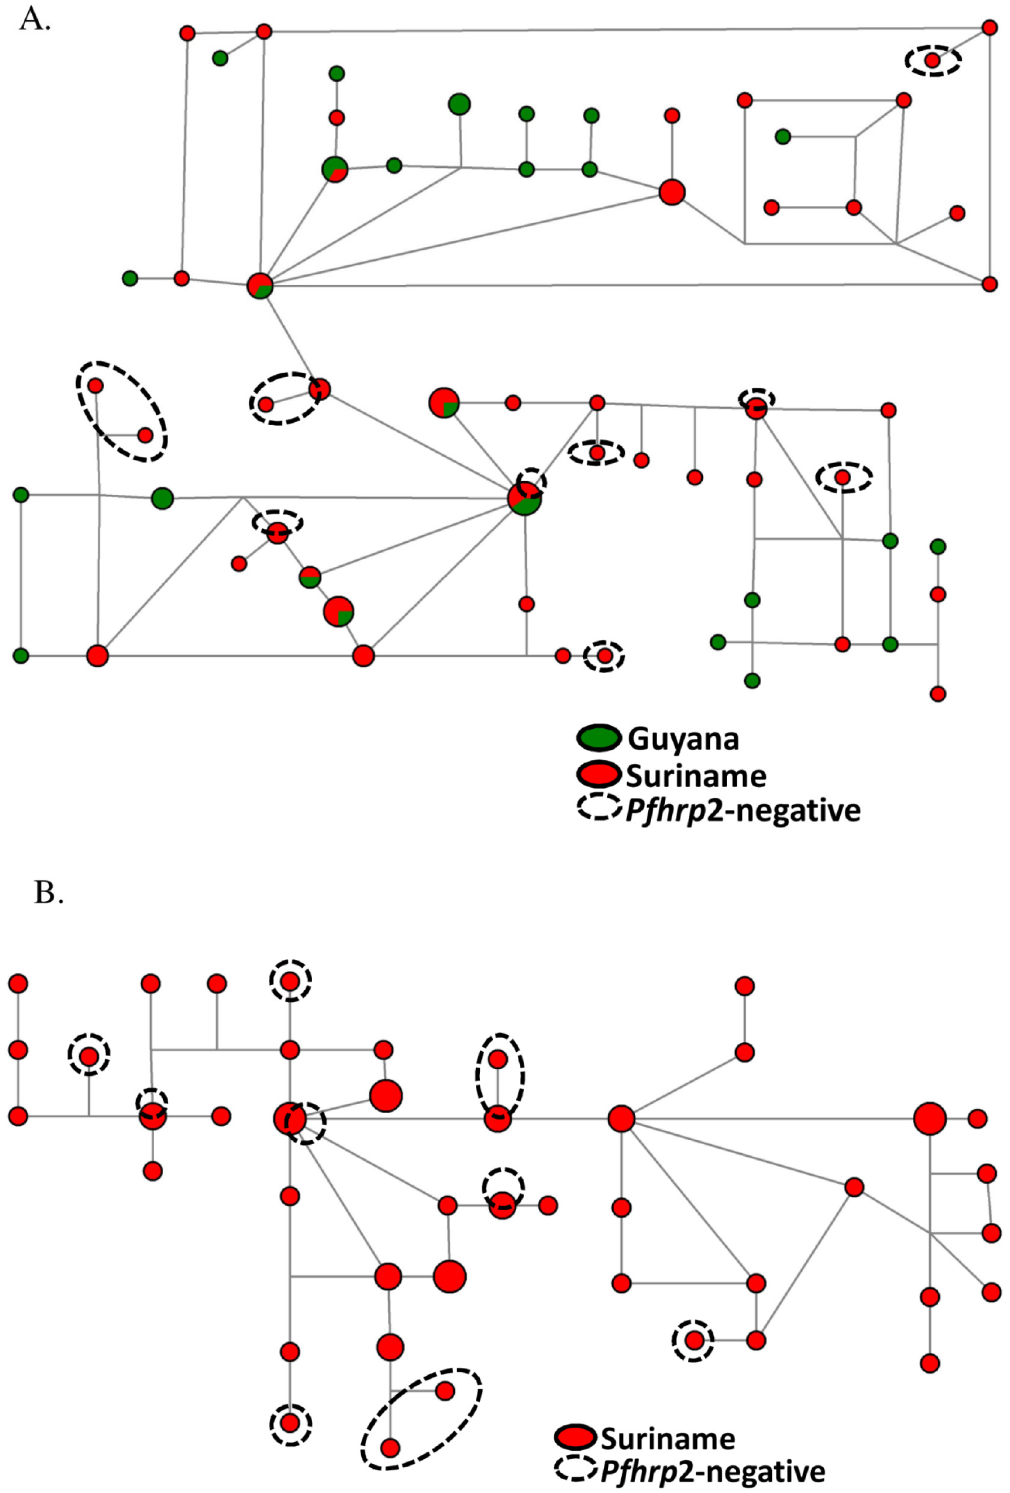
Fig 4. Median joining network analysis of P . falciparum isolates collected in (A) Guyana (N = 97) and Suriname (N = 57) and (B) Suriname alone (N = 57). The genetic relationships among parasites were constructed using seven neutral microsatellite loci, which have been used previously to genetically characterize P . falciparum parasite populations in South America. P . falciparum parasite isolates from Guyana are shown in green while those collected in Suriname are rendered in red. Dotted circles indicate pfhrp2 -negative isolates.